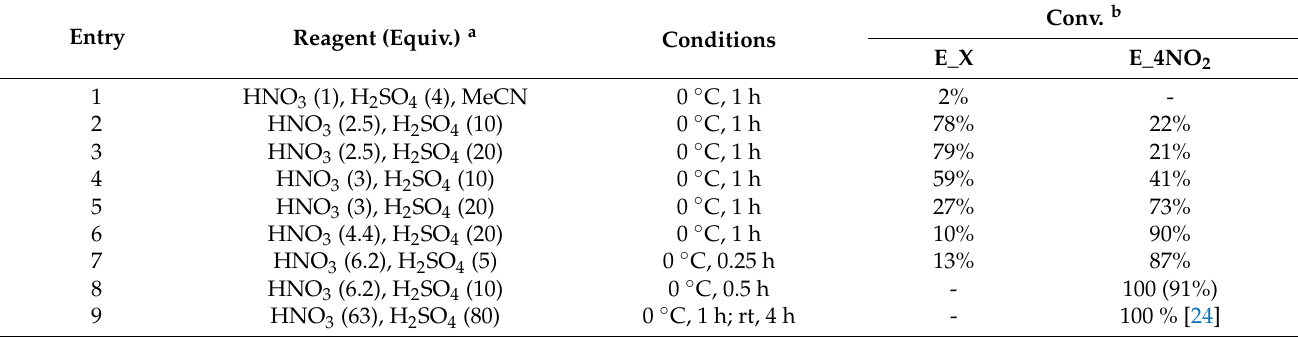
Table 4. Nitration of emodin with HNO 3 and H 2 SO 4 .